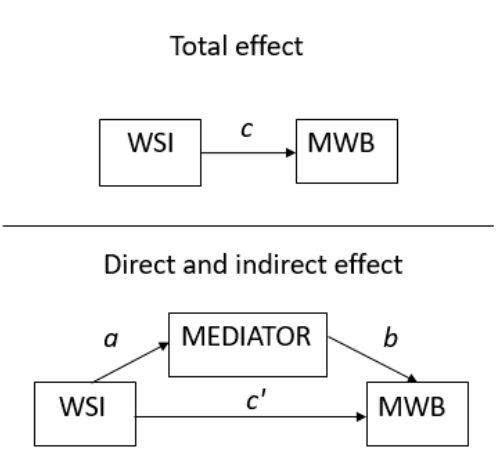
Figure 1. Mediation diagram denoting WSI effect on mental wellbeing with and without mediating aspects of ing aspects of WSI.